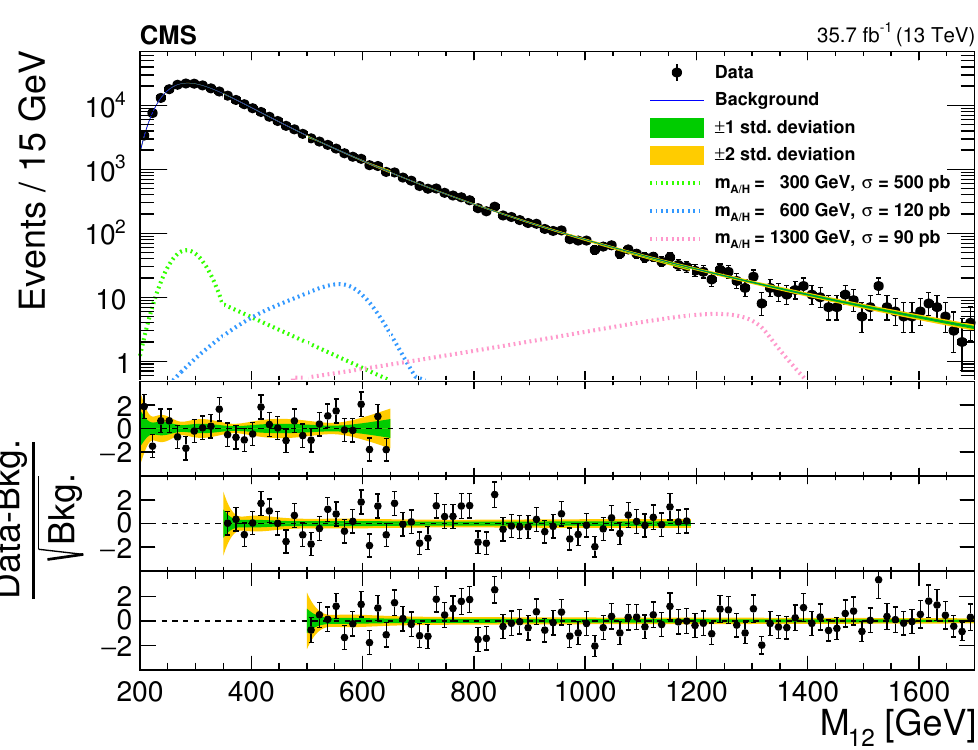
Figure 5 . Distribution of the dijet invariant mass M 12 in the data triple b tag sample showing the three subranges together with the corresponding background-only (cid:12)ts. The shaded area shows the post-(cid:12)t uncertainty. For illustration, the expected signal contribution for three representative mass points is shown, scaled to cross sections suitable for visualization. The change of slope around 350 GeV of the 300 GeV signal shape is caused by wrong jet pairing. In the bottom panels the p normalized di(cid:11)erence ((Data-Bkg)/ Bkg), where Bkg is the background as estimated by the (cid:12)t, for the three subranges is